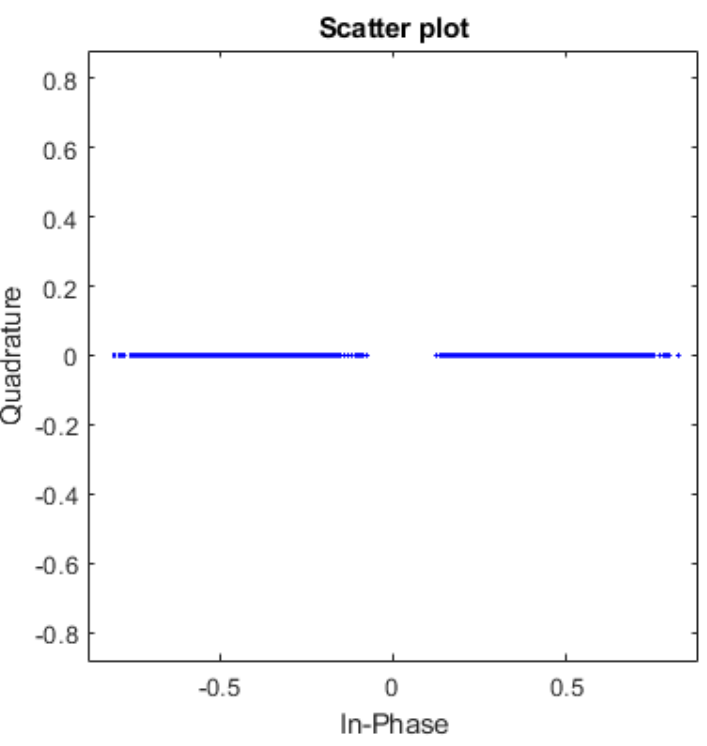
Figure 8. Scatter plot of received symbols after symbol timing recovery.